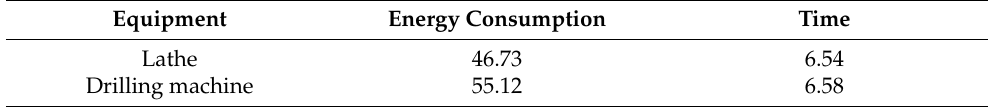
Table 6. Comparison of Different Equipment Optimization Results.